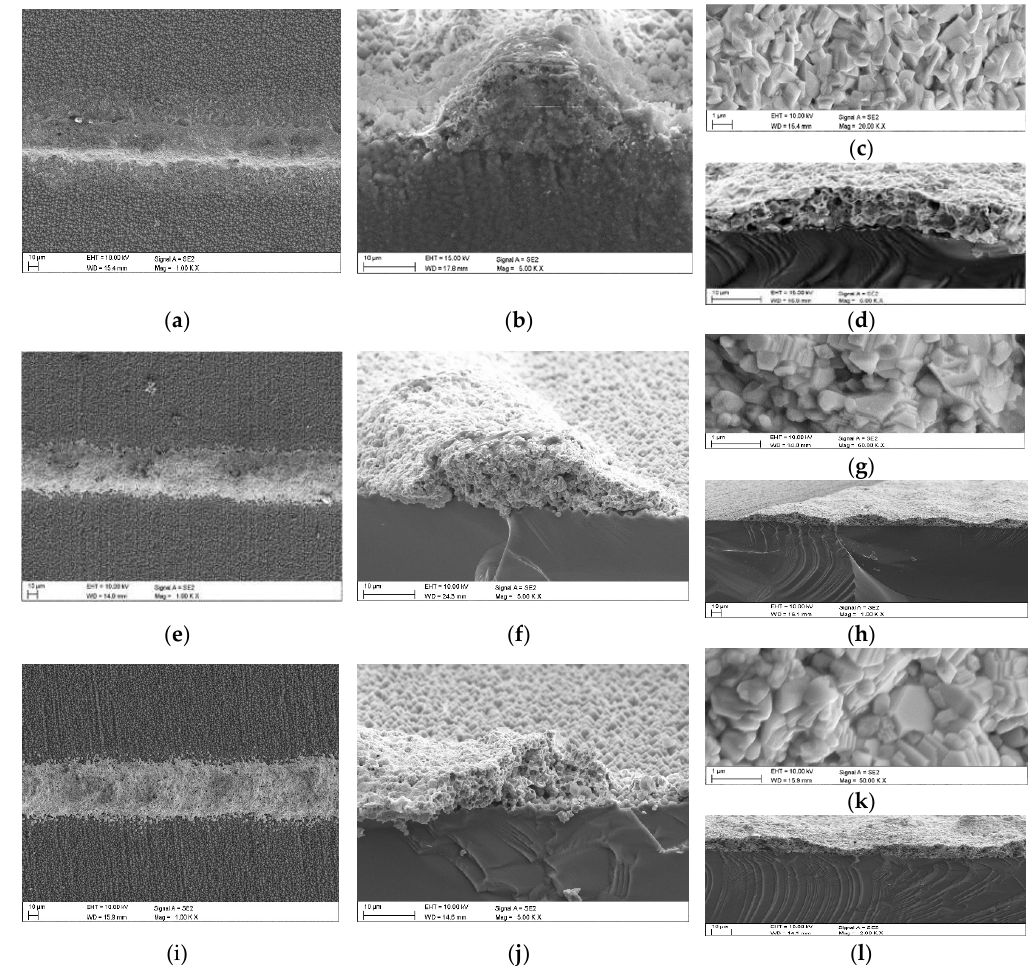
Figure 7. Surface layer topography made from paste A ( a , c ), paste B ( e , g ), and REF paste ( i , k ) on silicon surface and deposited by screen printing method and metallized in an IR furnace. Fracture of front electrode from paste A ( b , d ), paste B ( f , h ), and REF paste ( j , l ) obtained by SEM method.